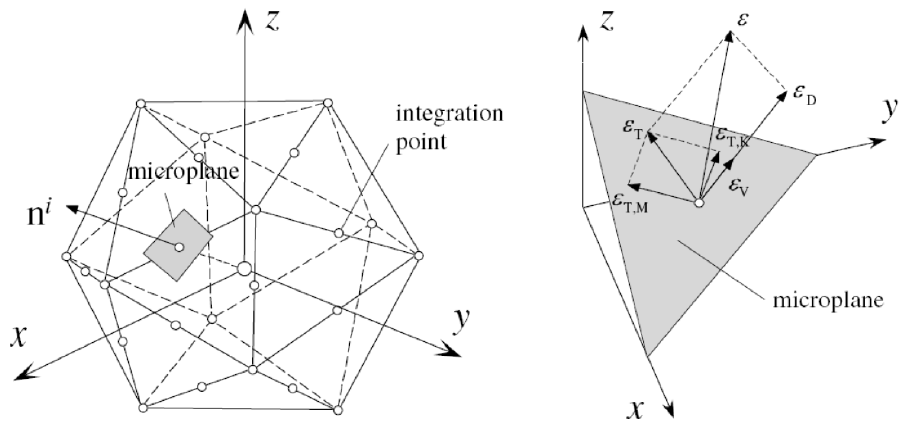
Figure 3. Concept of the microplane model: integration point with microplanes ( left ) and decomposition of strain vector on the specified microplane ( right )—Figure taken from [16].